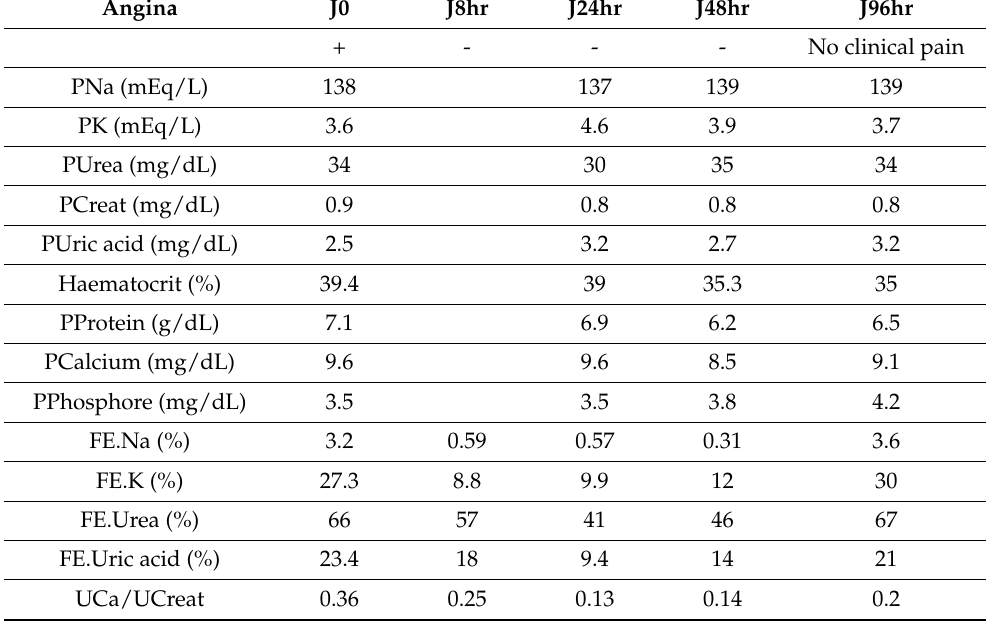
a FE.Na of 3.2% and a FE.K of 27.3%; eight hours later the FE.Na decreased to 0.59% and